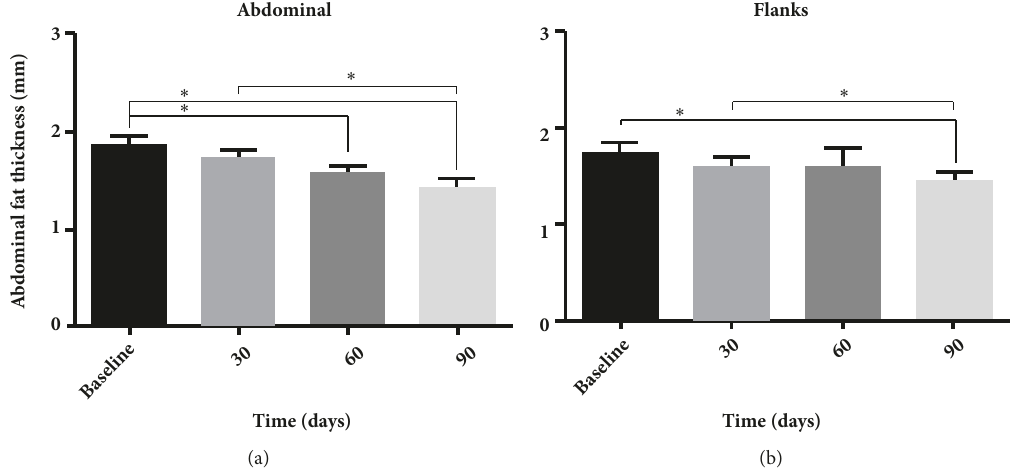
Figure 6: Means, with standard error of the mean, from an (a) abdominal fat-thickness assessment through diagnostic ultrasound before treatment (baseline) and after treatment (30, 60, and 90 days after treatment) and a (b) flank fat-thickness assessment through diagnostic ultrasound before treatment (baseline) and after treatment (30, 60, and 90 days after treatment). ∗ P <